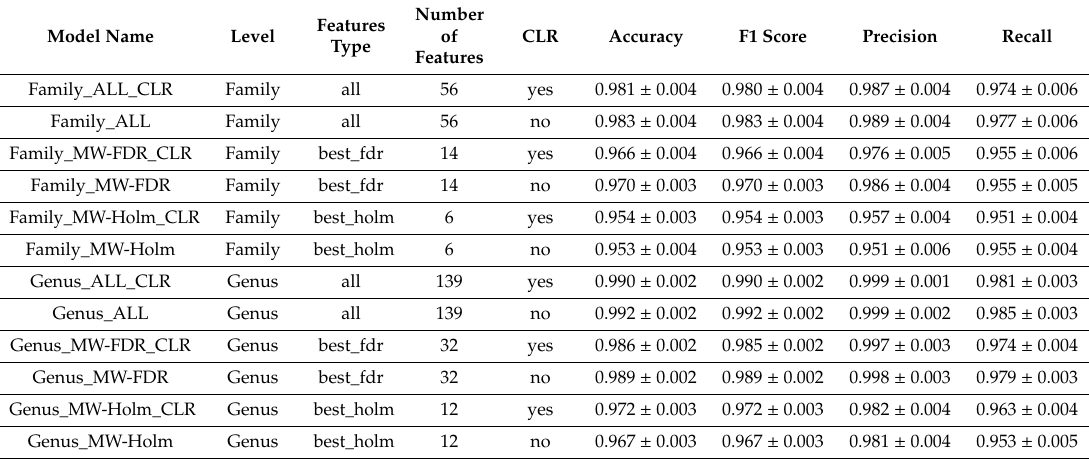
Table 2. Out-of-bag estimations of model